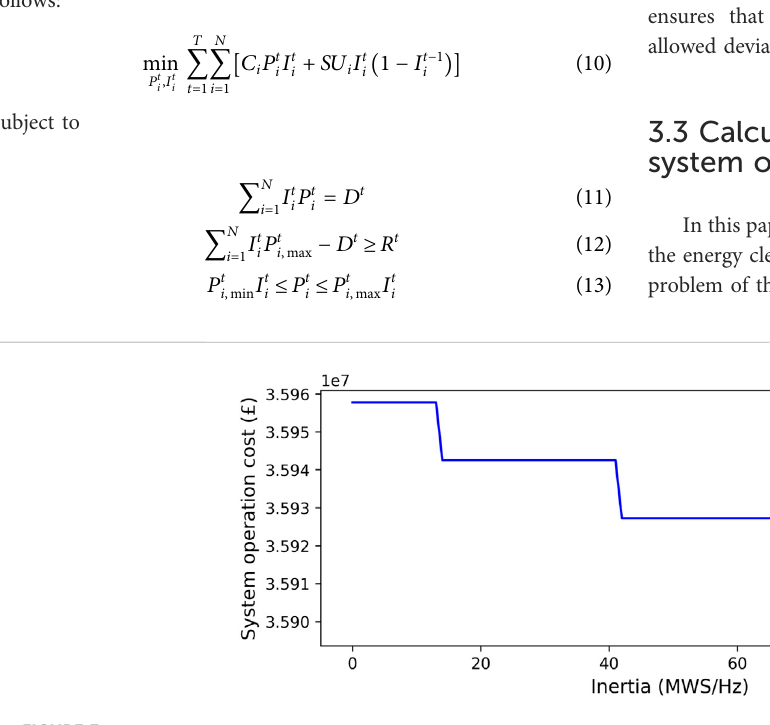
FIGURE 3 Impact of inertia volume on system operation